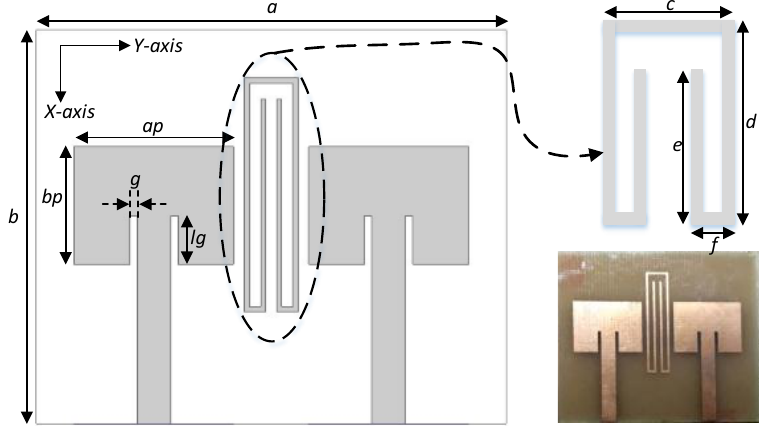
Figure 5. Geometry of the proposed MIMO antenna with decoupling structure ( a p = 16.8, b p = 12.91, W s = 3.1, g = 0.7, and lg = 7, a = 44, b = 37, c = 5, d = 22, e = 20, f = 2 [unit = mm]) and fabricated